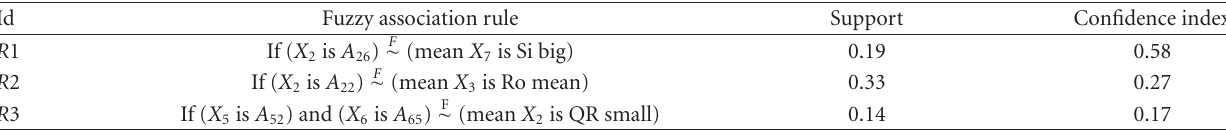
Table 7: Fuzzy extraction rules extracted from the residential buildings dataset.